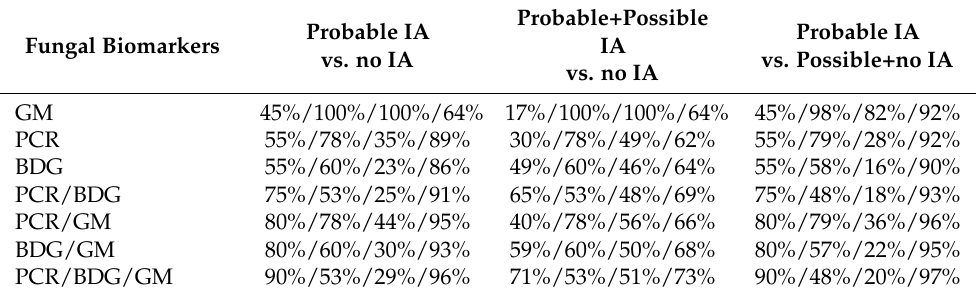
Table 2. Test characteristics (sensitivity/specificity/positive predictive value/negative predictive value), of each fungal biomarker alone and in combination for differentiating patients with probable IA, possible IA and no evidence for IA.